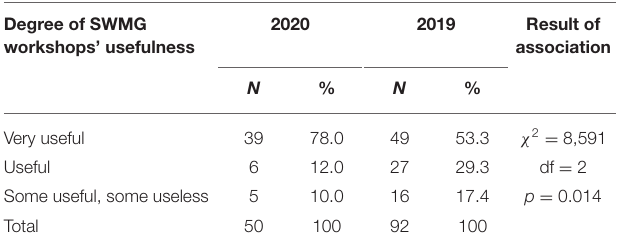
TABLE 3 | The general self-assessment of social work methods with groups workshops in terms of their usefulness for field practise by cohort/learning